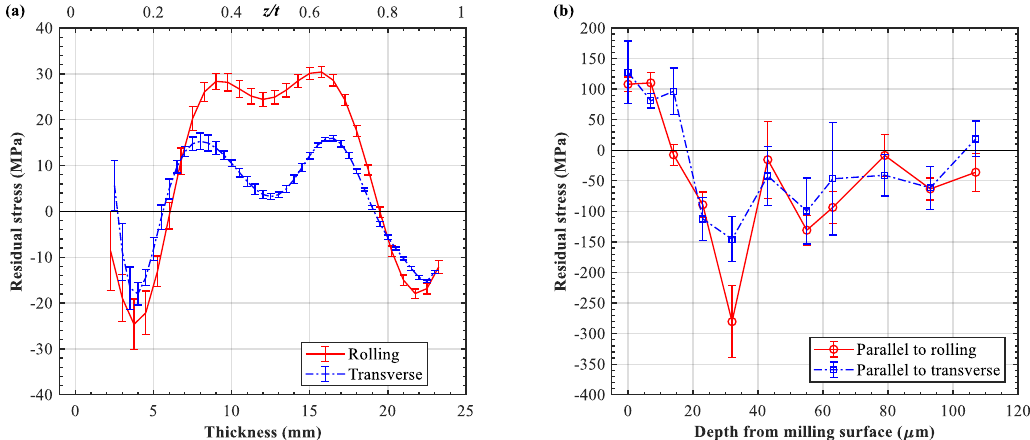
Figure 1. Initial conditions of residual stress of sheet samples: ( a ) bulk residual stress of base plate and ( b ) milling-induced near-surface residual stress.